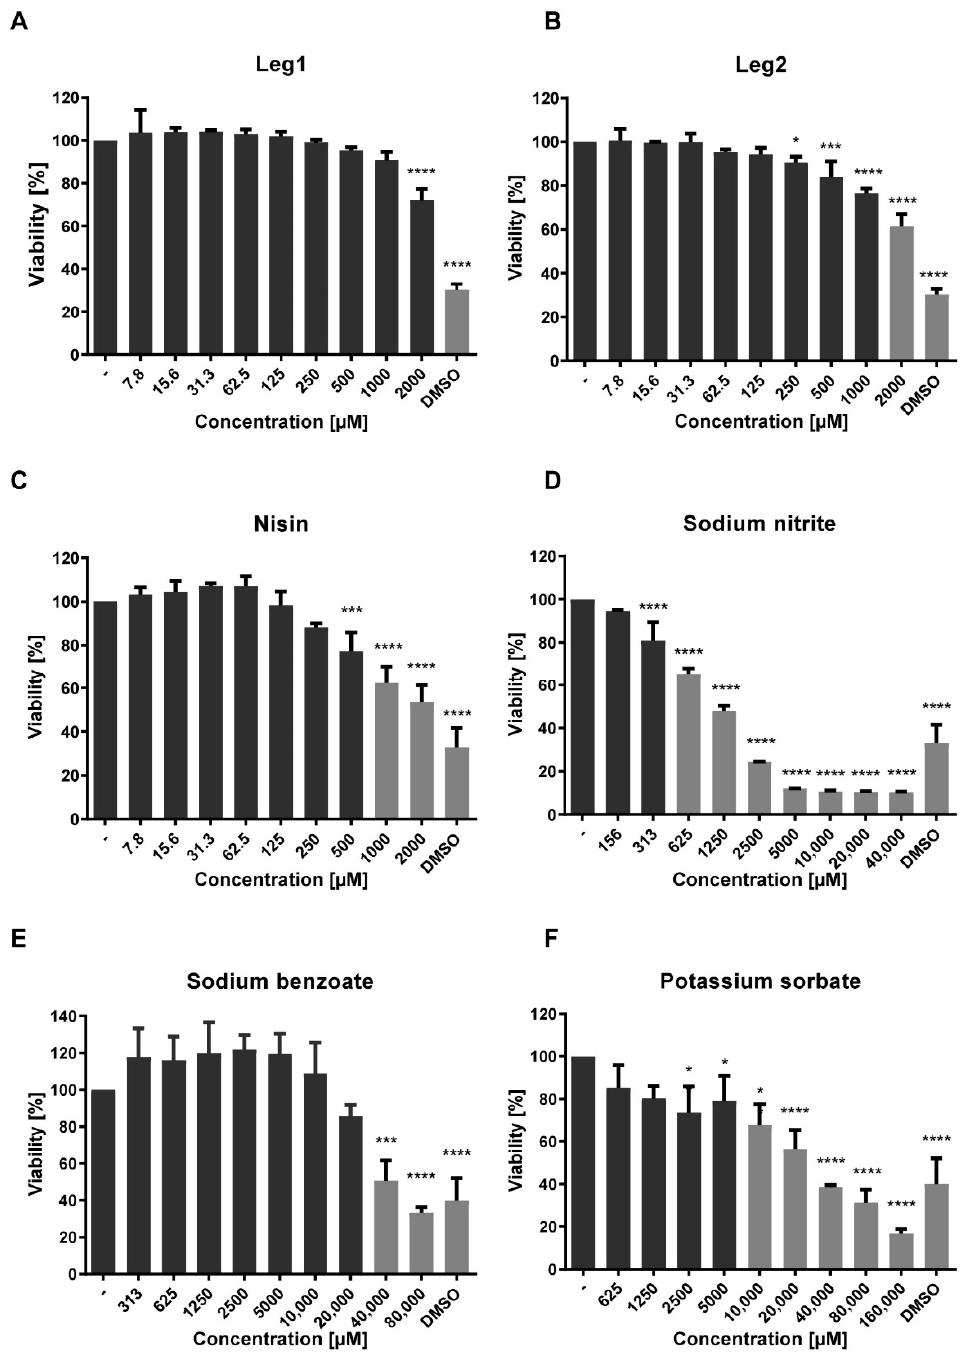
Figure 5. Influence of ( A ) Leg1, ( B ) Leg2, ( C ) nisin, ( D ) sodium nitrite, ( E ) sodium benzoate, and ( F ) potassium sorbate on the viability of Caco-2 cells as determined by the MTT assay. Water ( − ) was used as negative control and 10% DMSO as positive control. Viability (as mean ± SD of triplicates) is expressed as percentage in relation to the negative control. Cytotoxic effects (viability < 70%) are highlighted in light gray. The levels of significance were * p < 0.05, *** p < 0.001, **** p <